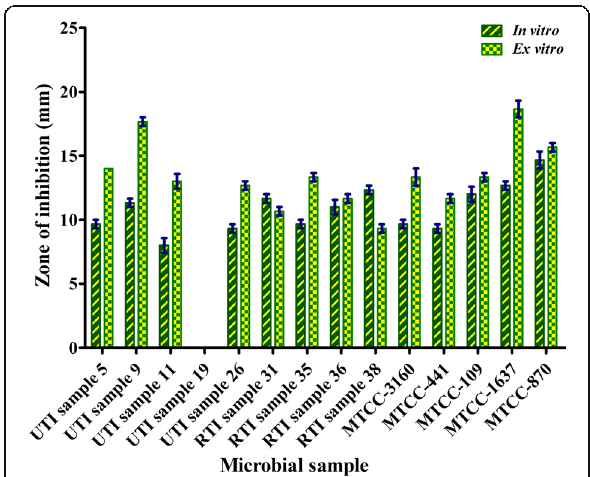
Fig. 3 Antimicrobial activities of the methanolic extracts of in vitro and ex vitro raised plants of Bacopa monnieri. (Sample 5, 9, 11, 19, 26, 31, 35, 36, and 38 are clinical isolates of MDR human UTI and RTI bacteria; MTCC 109, 441 and 3160 are standard bacterial strains and MTCC 870 and 1637 are standard fungal strains of microbial type culture collection